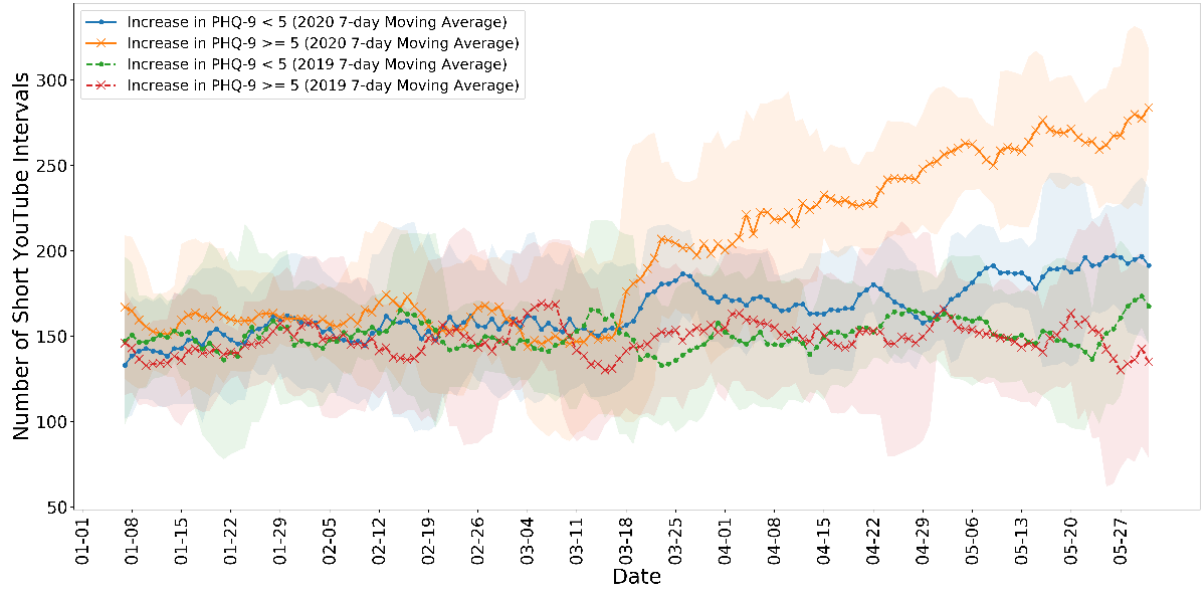
Figure 6. The 7-day moving average time series of the total amount of short YouTube activity intervals between groups with and without significant increases in the PHQ-9 depression scores. PHQ-9: Patient Health Questionnaire-9.